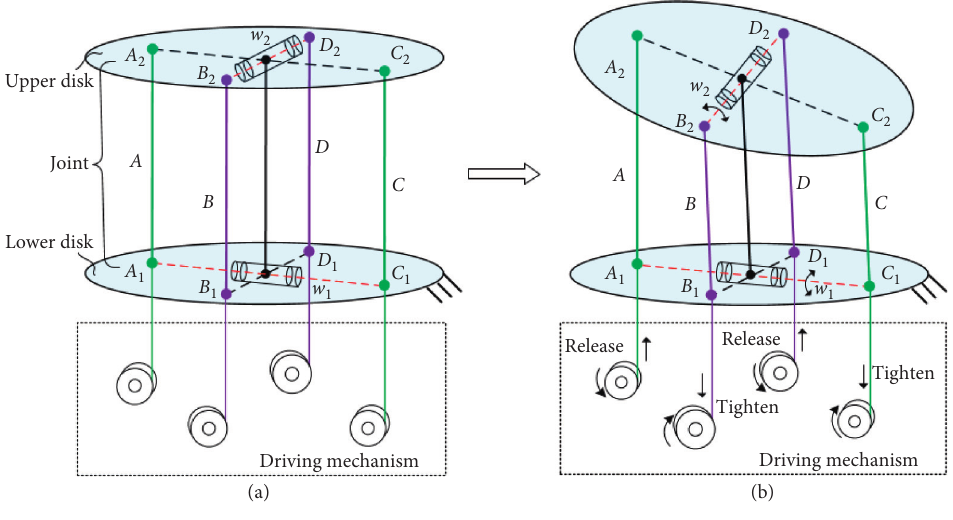
Figure 2: A novel joint without coupling effects.